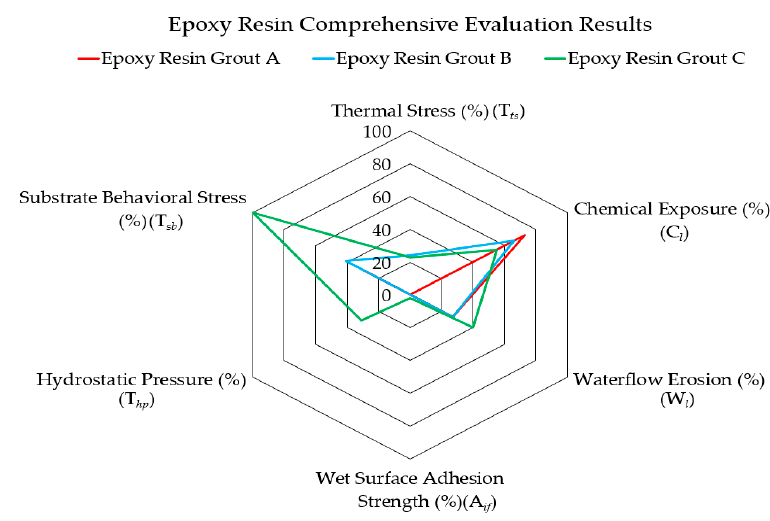
Figure 14. The physical property changes of the epoxy-resin grout-injection material.